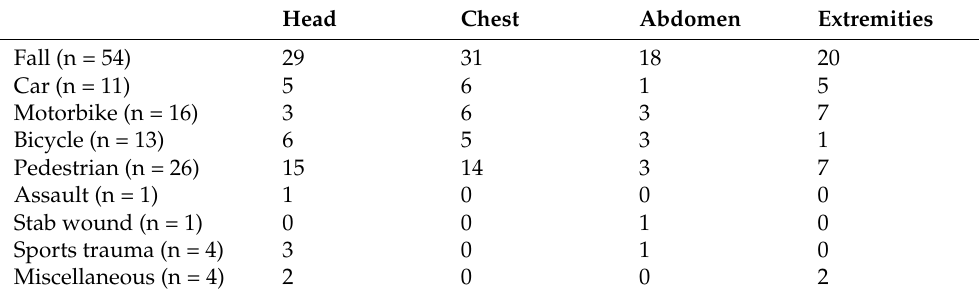
Table 3. Anatomical distribution of major injuries (AIS15 > 2) in major trauma according to trauma